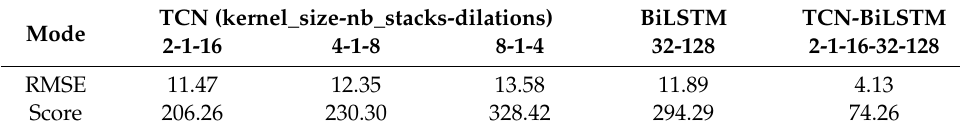
Table 4. RUL prediction results of 100 engines under different